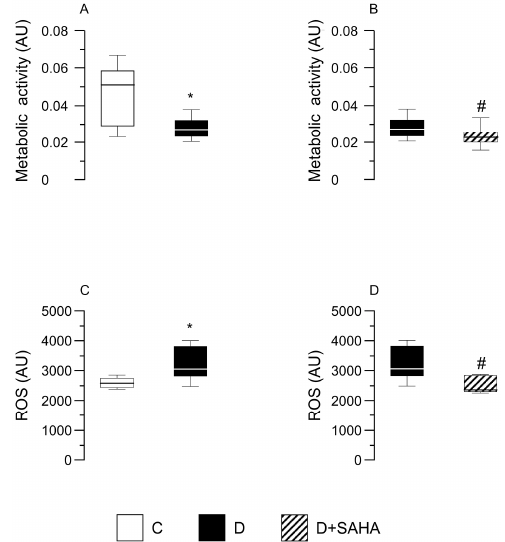
Figure 4. E ff ect of SAHA treatment on CMs’ metabolic activity and intracellular ROS content. Data are reported as median values and interquartile range. In left panels: E ff ect of diabetes on CM metabolic activity ( A ) and ROS levels ( C ), compared with control cells. Mann–Whitney U-test: * p < 0.05 vs. group C. In right panels: metabolic activity ( B ) and ROS content ( D ) measured in diabetic CMs before and after SAHA-exposure. Cells were isolated from the heart of three normal rats (group C) and five diabetic rats (groups D and D + SAHA). AU = arbitrary units. # p < 0.05 vs. D group; Wilcoxon matched-pairs signed rank